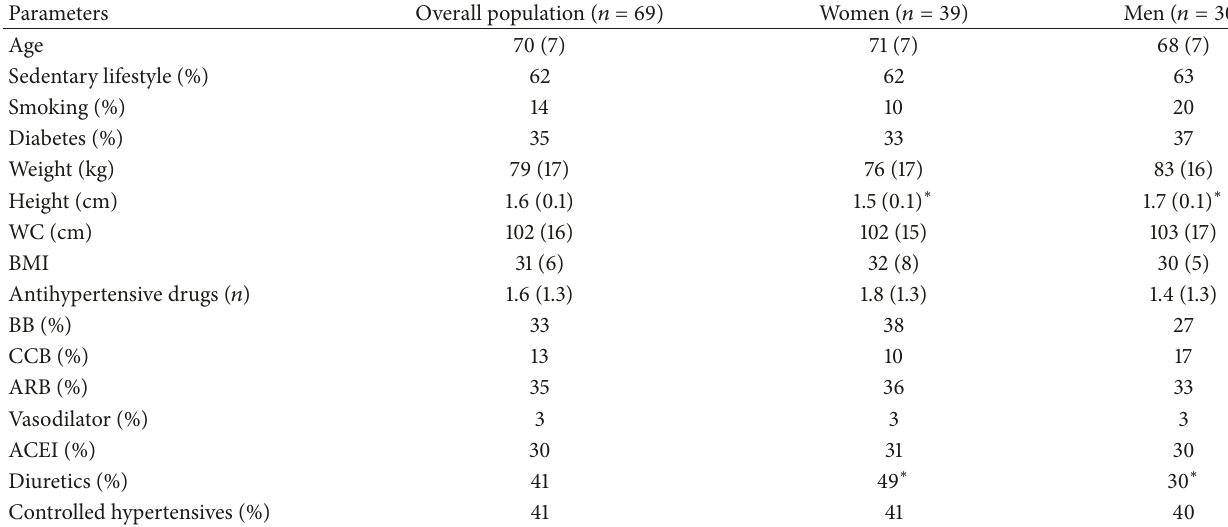
Table 1: Clinical characteristics of the groups and the number of antihypertensive